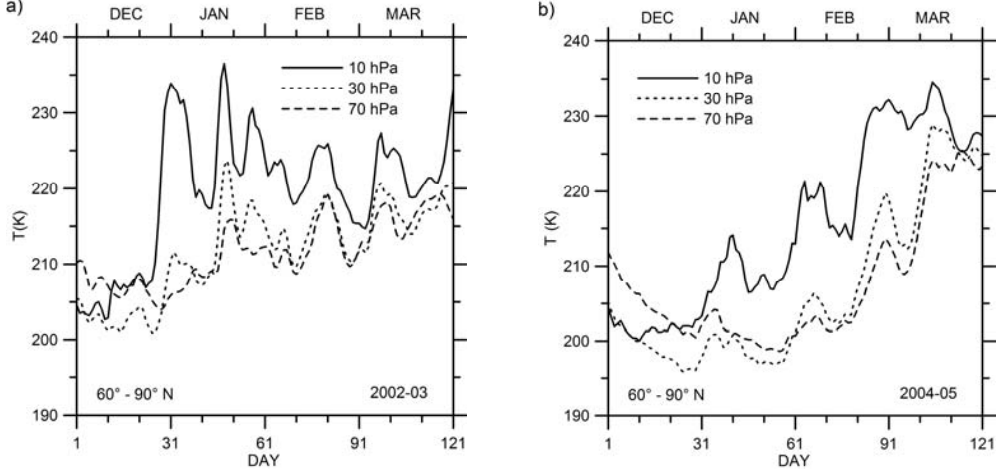
Fig. 2. Zonal mean temperature (K) averaged over 60 ◦ –90 ◦ N at 70, 30 and 10hPa from 1 December to 31 March (a) winter 2002–2003 and (b) winter